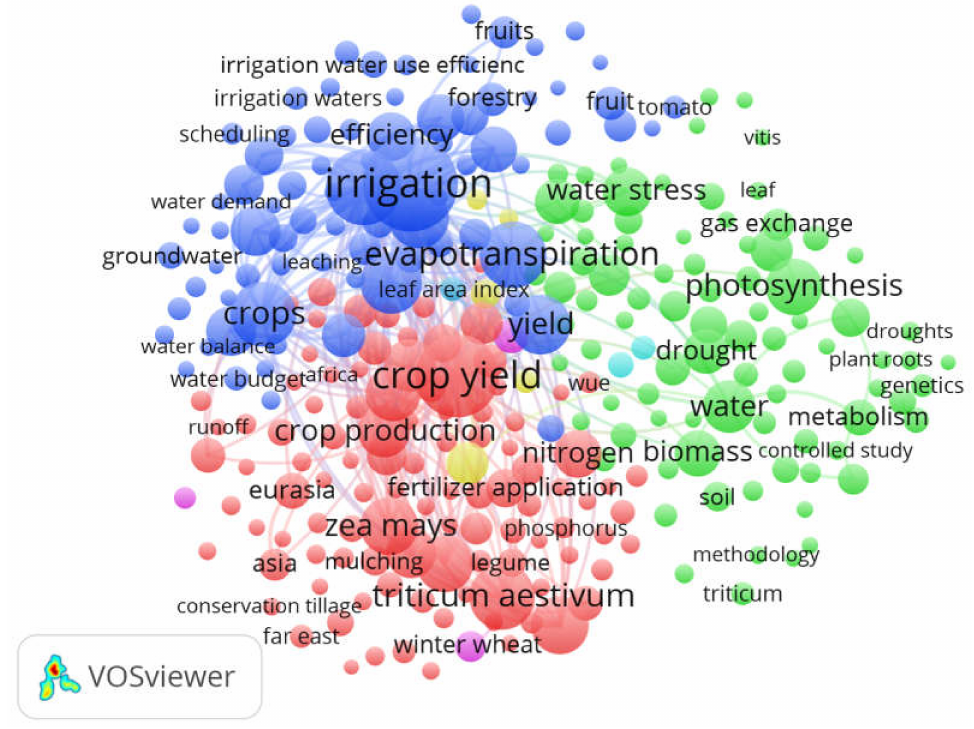
Figure 7. The concurrent network of the most common keywords in WUEA research for